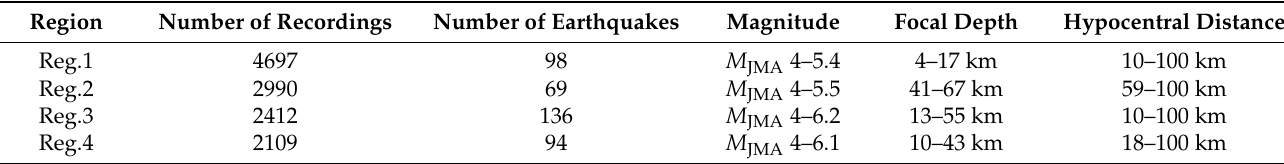
Table 2. Number of recordings and earthquakes, magnitude, focal depth, Hypocentral distance in each